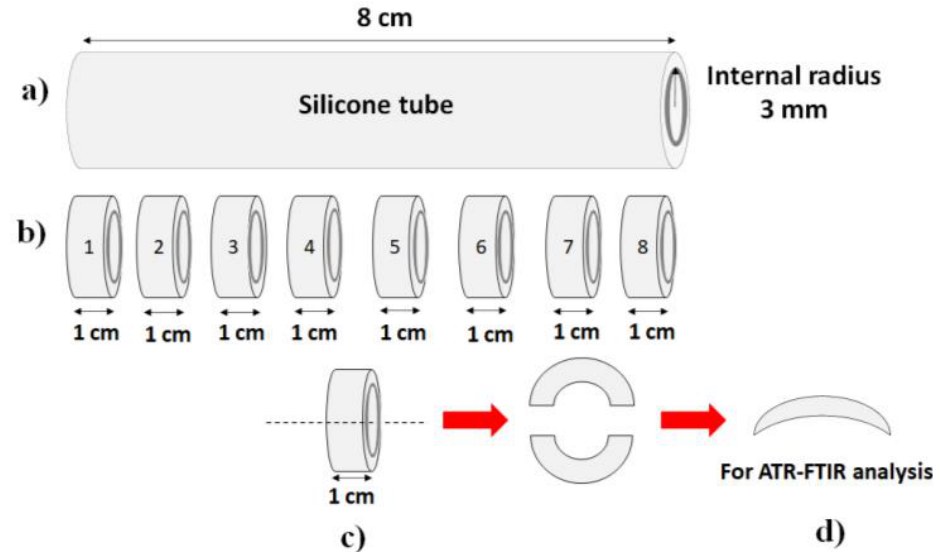
Figure 3. Schematic methodology of PP-MMA-coated silicone tube for ATR-FTIR analysis. ( a ) The silicone tube is 8 cm in length with an internal radius of 3 mm. ( b ) Shows eight tube sections equally cut to be 1 cm in length. ( c ) Shows 1 cm tube section cut from the middle position to make a flat sample for ATR-FTIR analysis. ( d ) Shows flat silicone tube for ATR-FTIR analysis.